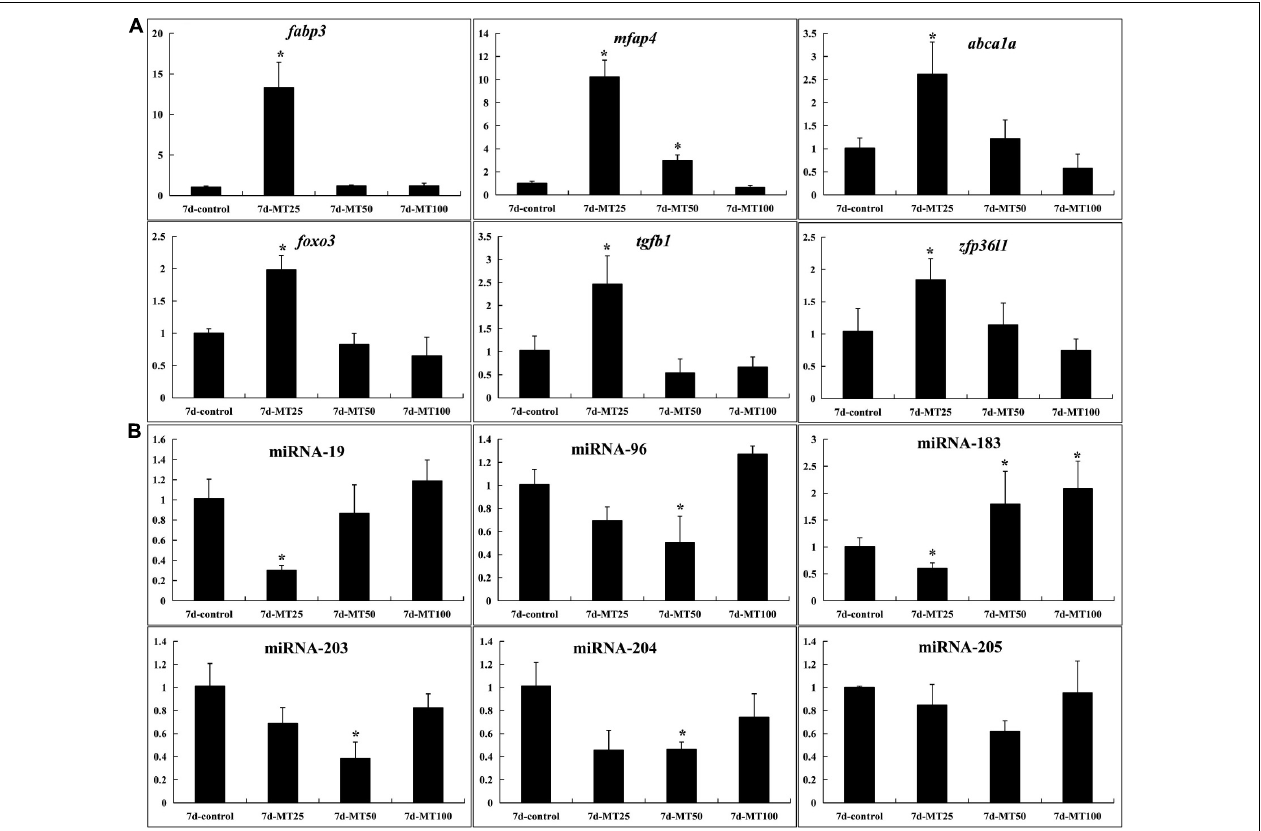
FIGURE 6 | qPCR verification ( n = 3). ef1 α and U6 were used as reference gene for genes and miRNAs, respectively. The data of treatment group and control group were analyzed using the 2 − (cid:49)(cid:49) Ct method. The results were represented as the mean ± SD of female fish. * p < 0.05. (A) Ovary RNA. (B) Ovary miRNA expression. The name of the genes and their potential functions are as follows: fabp3 (fatty acid-binding protein 3, related to apoptosis), mfap4 (microfibrillar-associated protein 4, immune response with bacterial challenge), abca1 (ATP-binding cassette transporter A1, cholesterol metabolism), foxo3 (forkhead transcription factor 3a, TGF β -induced apoptosis and longevity), tgfb1 (transforming growth factor β 1, disease like apoptosis and tumor), and zfp36l1 (the tristetraprolin or tristetraprolin family of CCCH tandem zinc finger proteins, TNF α